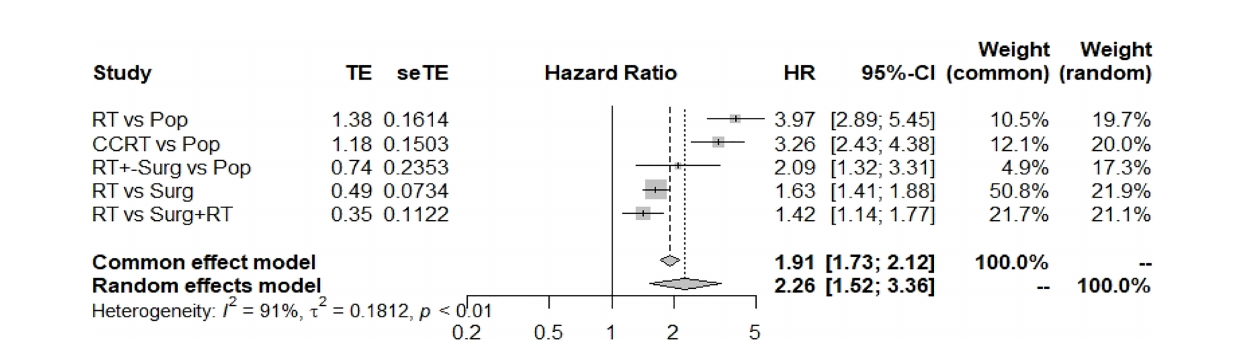
FIGURE 2 | Summary of the hazard ratios for CVD for different treatment methods. Pop, population; RT, radiotherapy; Surg,